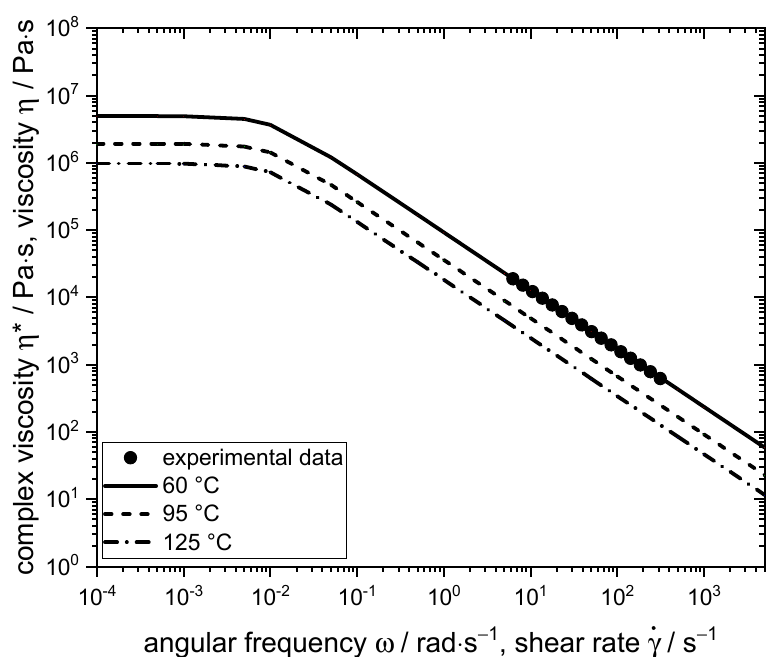
Figure 6. Experimentally determined complex viscosity as a function of the angular frequency at 60 °C (filled circles) and the fitted viscosity curves at 60, 95, and 125 °C, which were based on the Bird–Carreau model.